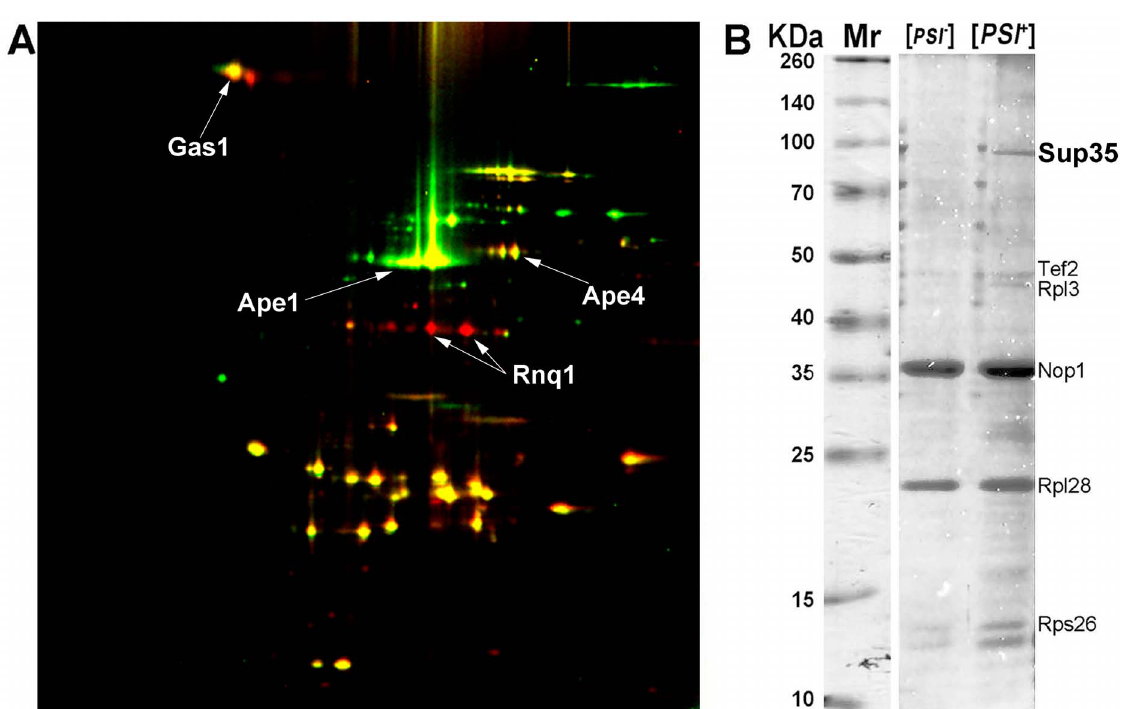
Fig. 4. 2D-DIGE image of proteins of sarkosyl-insoluble aggregates isolated from the GT81-1C [ PSI + ][ PIN + ] strain and its [ psi 2 ][ pin 2 ] derivative (A). Spots corresponding to proteins from [ PSI + ][ PIN + ] lysate and the [ psi 2 ][ pin 2 ] control are red and green, respectively, while yellow spots correspond to proteins present in both compared samples. SDS-PAGE image of proteins from the same DRAFs that were insoluble in UTC buffer (B). Proteins identified by mass-spectrometry are indicated. Mr – protein molecular mass markers. Identification data are presented in Table 4; mass spectra are shown in S4 Table.